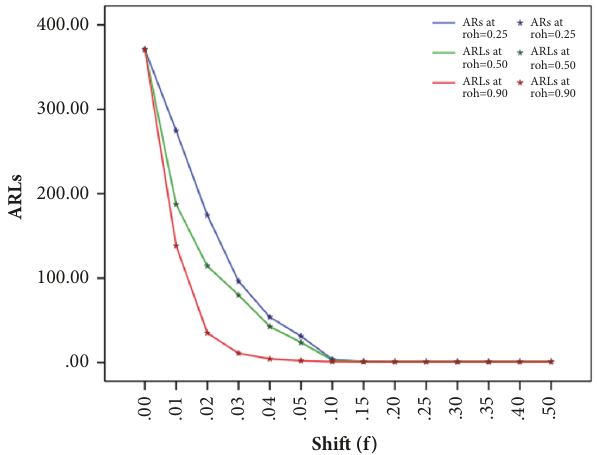
Figure 7: ARLs for proposed repetitive EWMA-RSS control chart using Khan et al. [8] ratio estimator, when 𝑟 𝑜 = 500 at 𝜆 = 0.1.